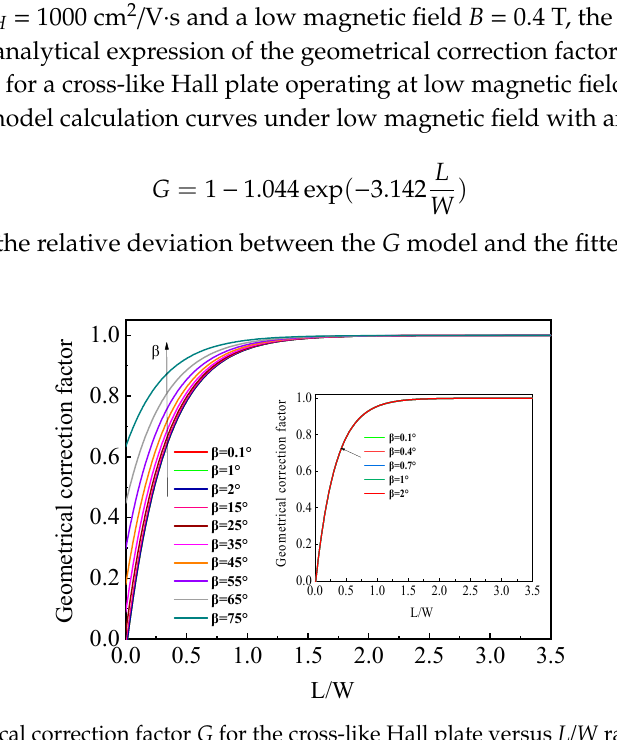
Figure 3. Geometrical correction factor G for the cross-like Hall plate versus L / W ratio at different Hall angles β .